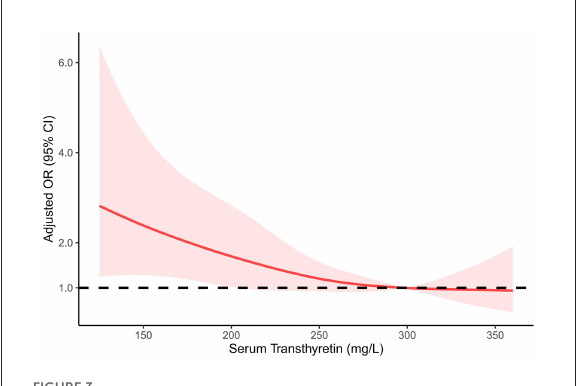
FIGURE3 Restricted cubic spline regression model of the relationship between serum transthyretin levels and intracranial